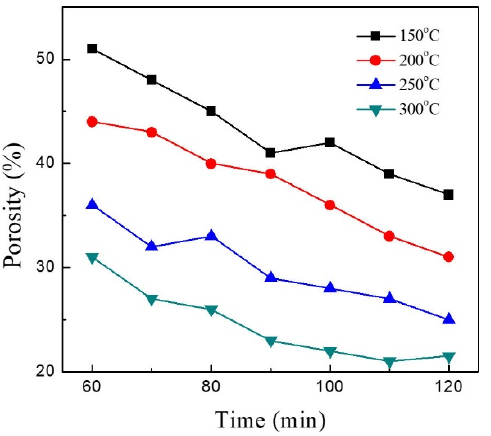
Figure 2. The porosity of the Ag nano paste joint at different temperatures. The microstructure of the sintered joint after sintering at different temperatures for 120 min is displayed in Figure 3. The Ag nano paste joint featured a sandwich structure: